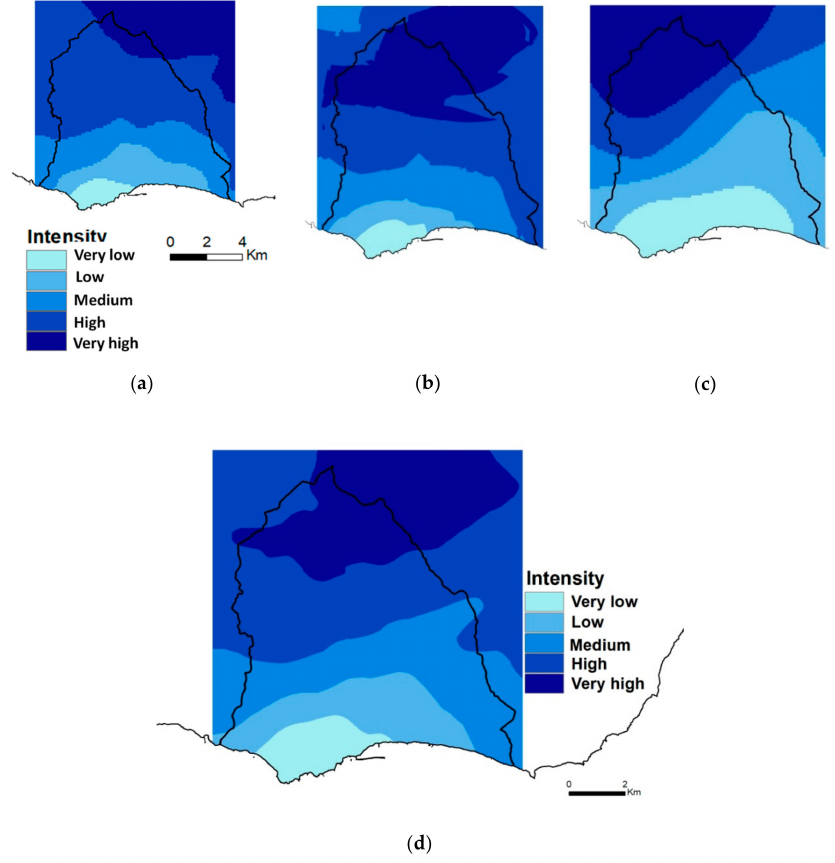
Figure 2. Spatial evaluation of intense precipitation based on: ( a ) and ( b ) average intensity of maximum precipitation in 1 h and 12 h; ( c ) 95th percentile of daily precipitation; ( d ) zonation of intense precipitation